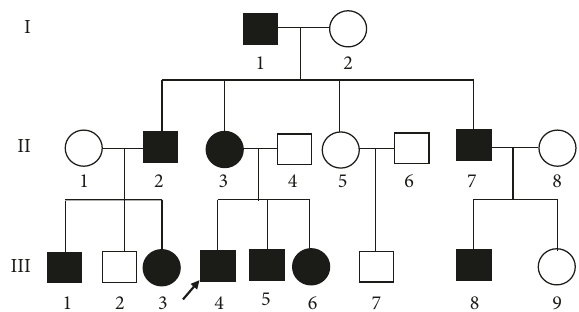
Figure 1: The genogram of the Indian family with kerotoconus. The squares and circles represent males and females, respectively. The solid symbols indicate the patients, while the open symbols indicate the unaffected individuals. The proband is denoted by the